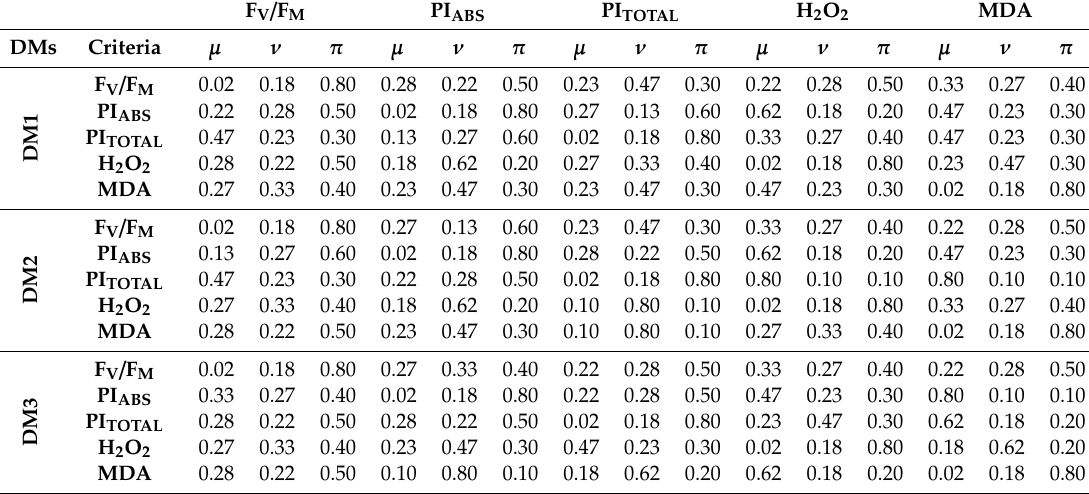
drought subcategories.